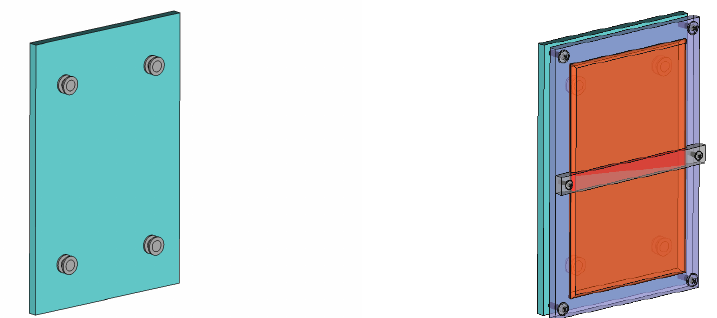
Figure 9. Practical use of small-scale dampers: left hand side, plate with small-scale damper proto- types attached; right hand side, vibration setup ready for testing.